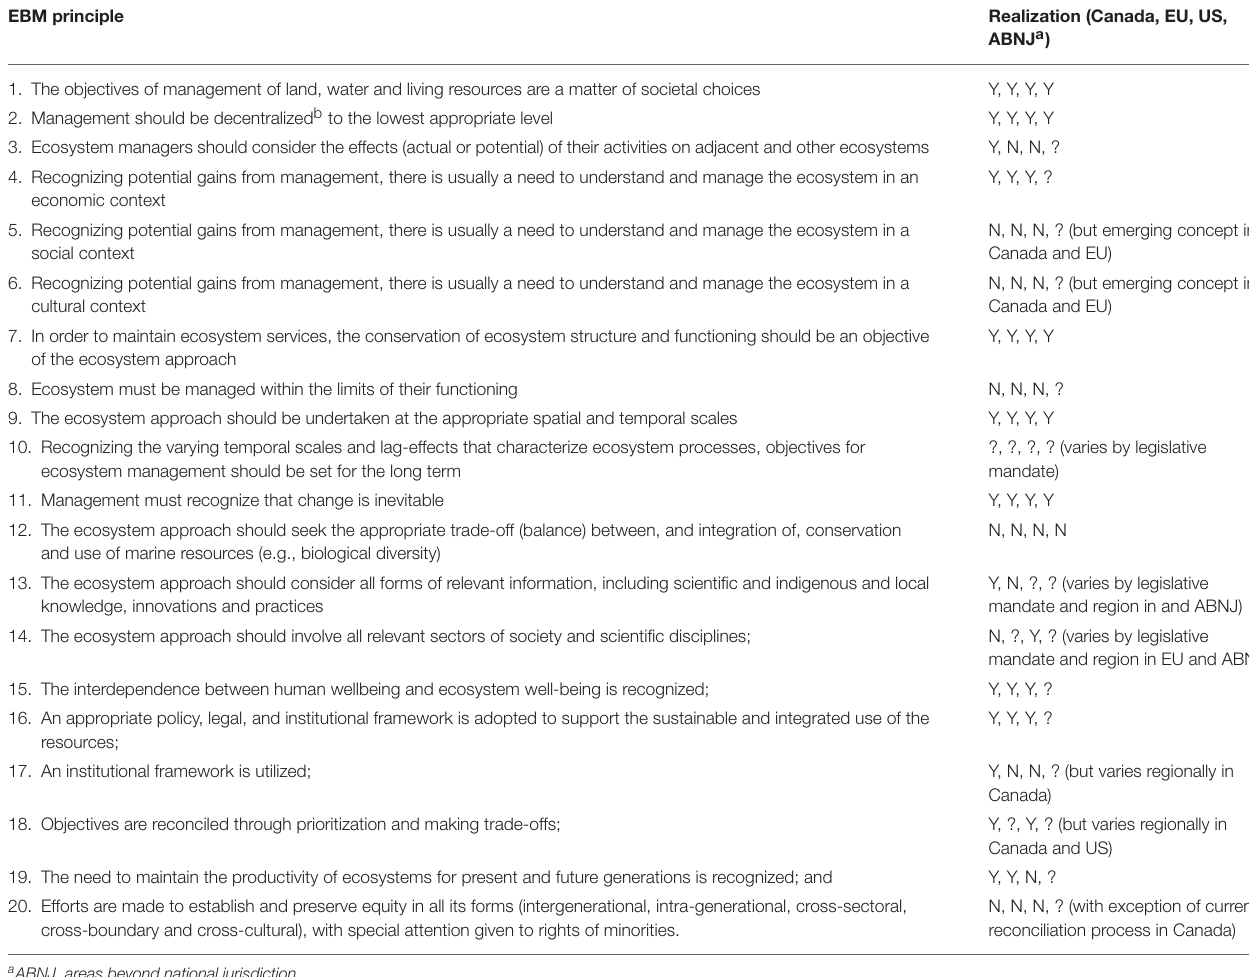
TABLE 1 | Principles considered in comparing and contrasting EBM implementation across jurisdictions, and expert opinion on realization level (for each jurisdiction in order, Y, yes; N, no; ?,